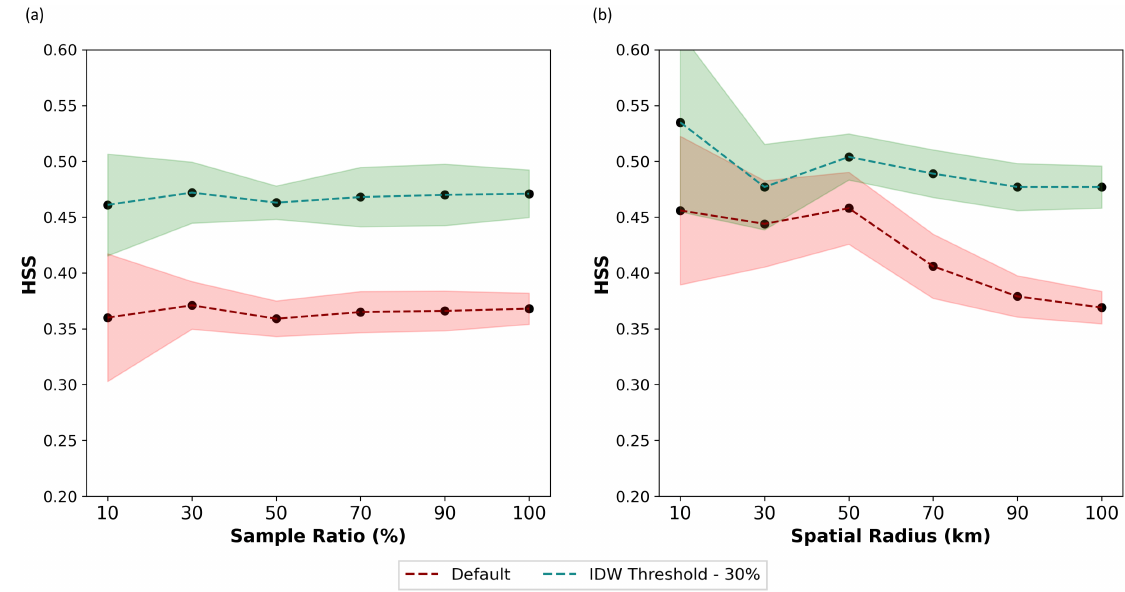
Figure 4. Sensitivity analysis showing how HSS for precipitation occurrence at Eureka varies as a function of: Sample Ratio (%) ( a ); and Spatial Radius (km) ( b ). The red dashed line shows results from the Default method, while the green dashed line shows results that include inverse distance weighting (IDW). The shaded region indicates the uncertainty in each estimate based on a n = 100 bootstrap resampling, with replacement (see Section 3.2 for more